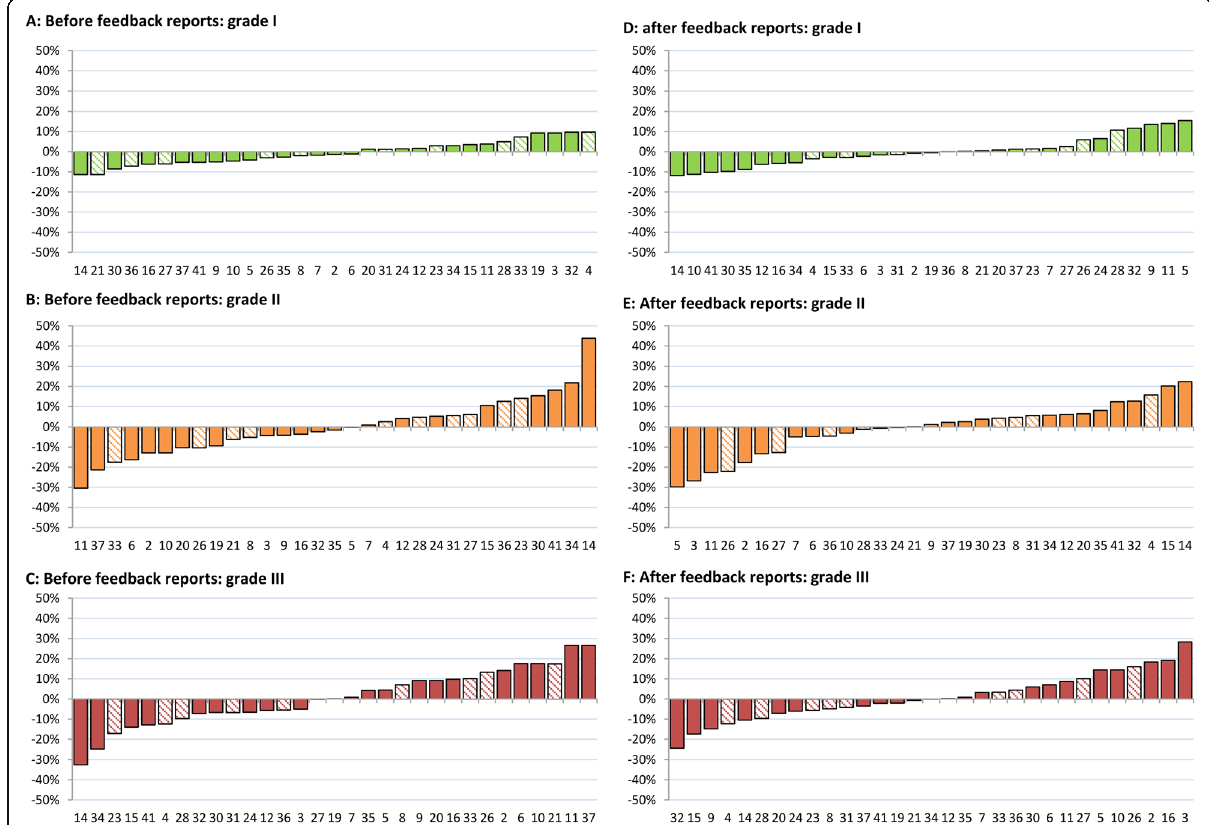
Fig. 1 Inter-laboratory ( n = 31) variation in histologic grading of ductal carcinoma in situ (DCIS) of the breast before ( a-c ) ( n = 1493) and after feedback reports ( d-f ) ( n = 1461). Percentages per laboratory show the absolute deviation from the national proportion per histologic grade for grade I (A + D), grade II (B + E) and grade III (C + F). Laboratory numbers for all sub-figures ( a-f ) correspond. All laboratories are ranged from lower (negative values) to higher proportions (positive values). A decrease in absolute range was observed for grades II and III; grade II ( − 22.0%), grade III ( − 6.2%). An increase was observed for grade I (+ 6.5%). Striped bars indicate laboratories who received feedback on pathologist ’ level ( n =